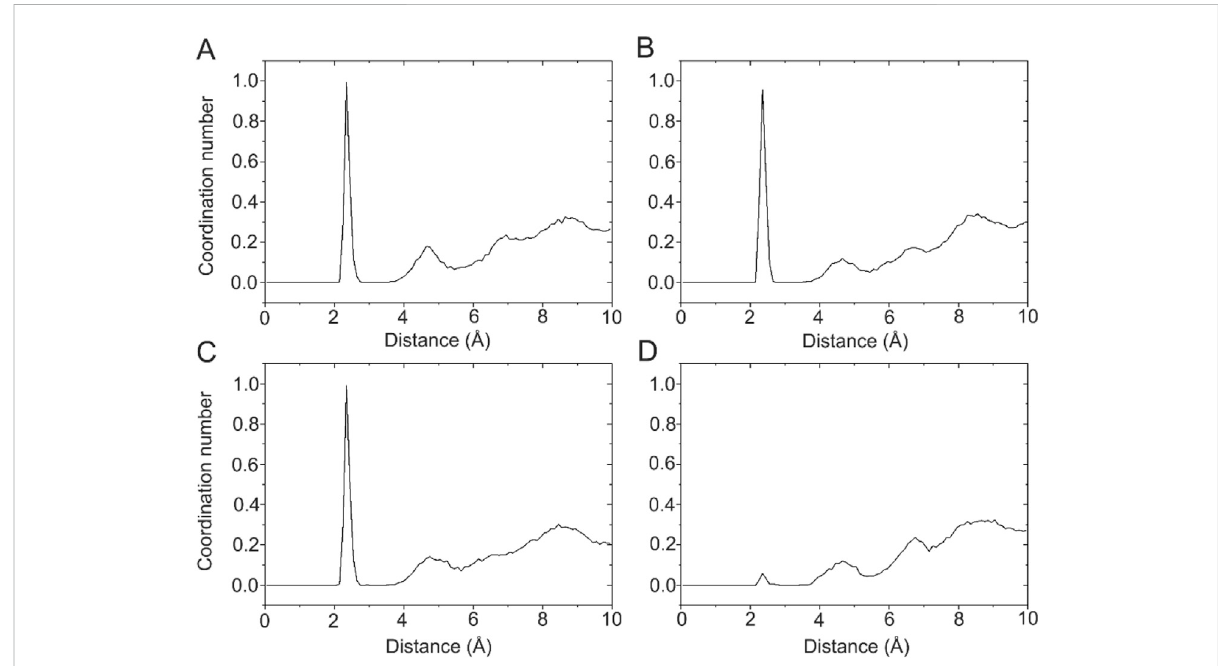
The coordination numbers of water molecules for the Ca 2+ in the CS1 (A) , CS2 (B) , NS1 (C) , and NS2 (D) binding sites in the Ca 2+ -bound